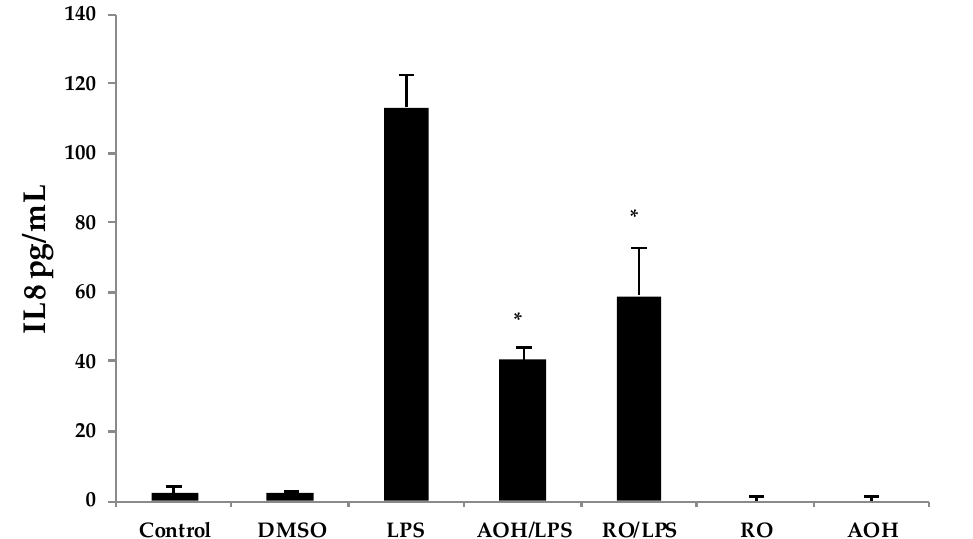
Figure 8. Treatment of airway epithelium cells by alternariol (AOH), RO-3306, and lipopolysaccharide (LPS). BEAS-2B cells seeded at a density of 5 × 10 5 cells/well were treated with 10 µ M of AOH or 10 µ M of RO-3306 in the presence and absence of 10 µ g of LPS and incubated for 24h. Supernatants were analyzed using enzyme-linked immunosorbent assay (ELISA). An * indicates p < 0.05 according to Student’s t -test for AOH/LPS and RO/LPS treatments compared to the LPS treatment alone.